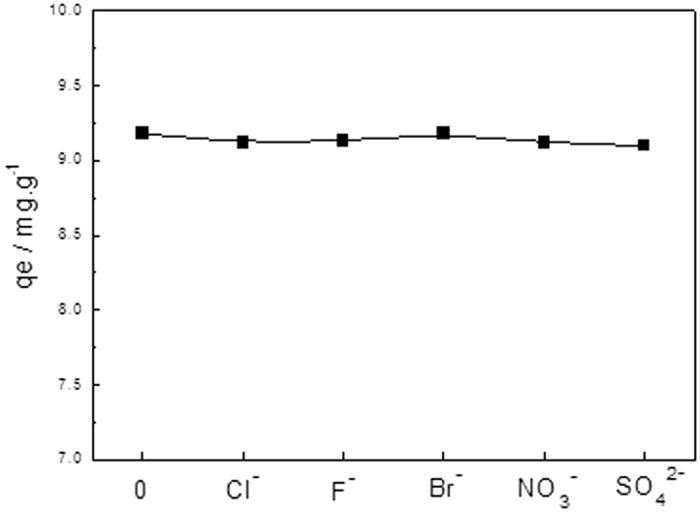
Effects of the Co-existing anions on the phosphate adsorption to Fe3O4@NH2-MIL-101(Fe).(Fe3O4@NH2-MIL-101(Fe), 12 mg; NaH2PO4 c0 = 0.6 mgL−1; V = 0.2 L; T = 293 K).